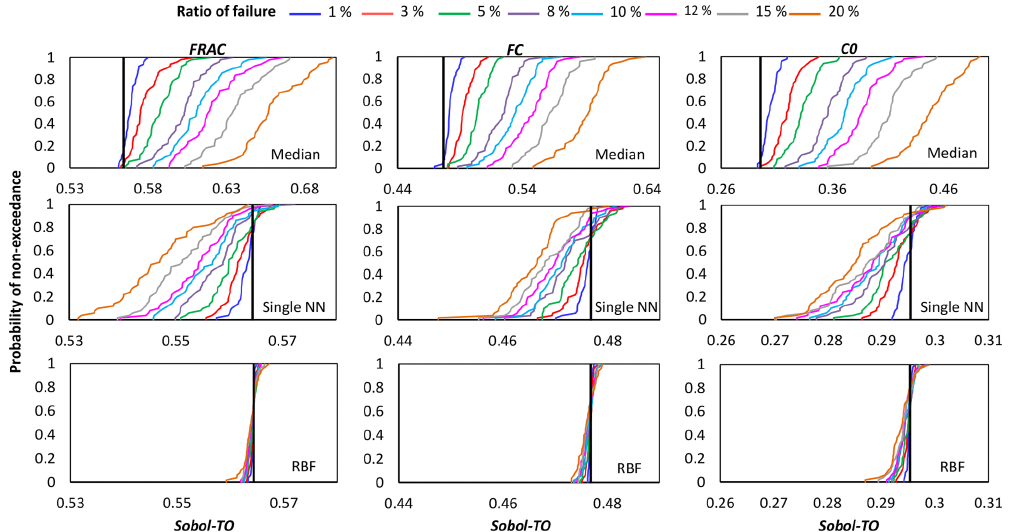
Figure B1. Comparison of the proposed crash-handling strategies in a sensitivity analysis of the HBV-SASK model using the variance-based algorithm for different ratios of failure. The CDFs of the sensitivity indices for strongly influential parameters { FRAC , FC , C0 } are compared in this plot. The vertical line (solid black) on each subplot represents the corresponding “true” sensitivity index obtained when there were no